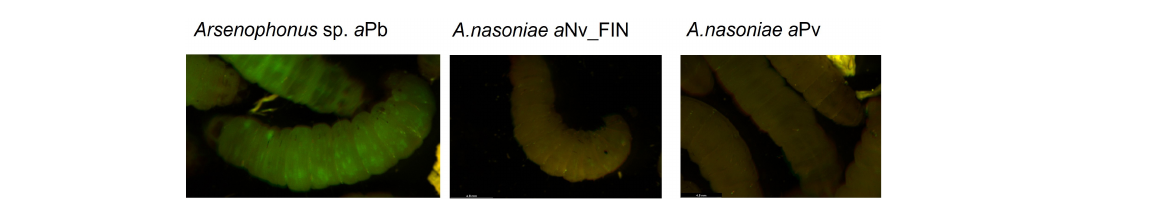
FIGURE4 Exemplar images of Galleria mellonella larvae 48 h post-infection with Arsenophonus sp. a Pb, A. nasoniae a Nv_FIN, and A. nasoniae a Pv. Each Arsenophonus strain carries the plasmid pOM1::GFP, and larvae are viewed on a binocular microscope under epifluorescence, with green fluorescent protein (GFP) emitting green under excitation.